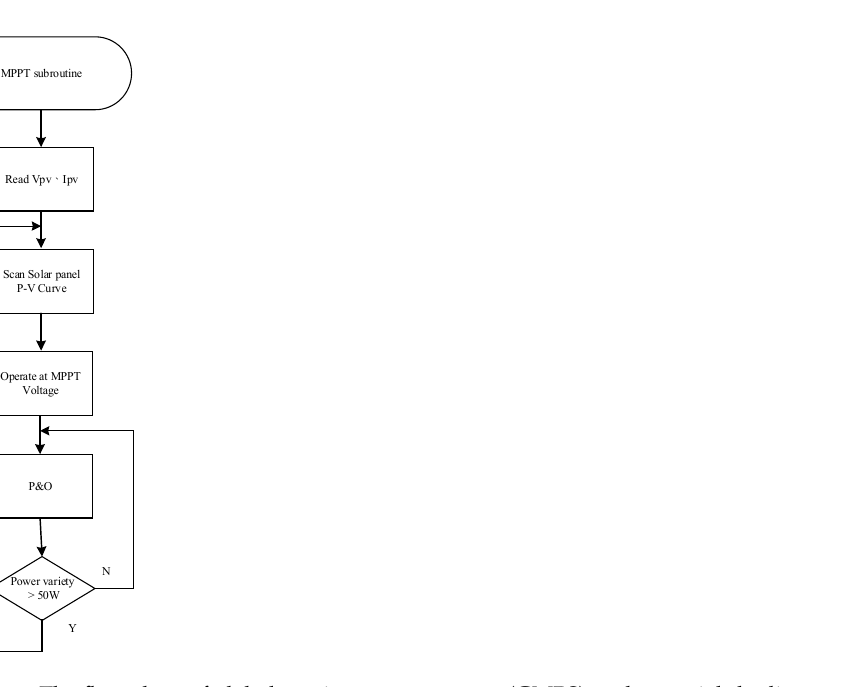
Figure 7. The flow chart of global maximum power scan (GMPS) under partial